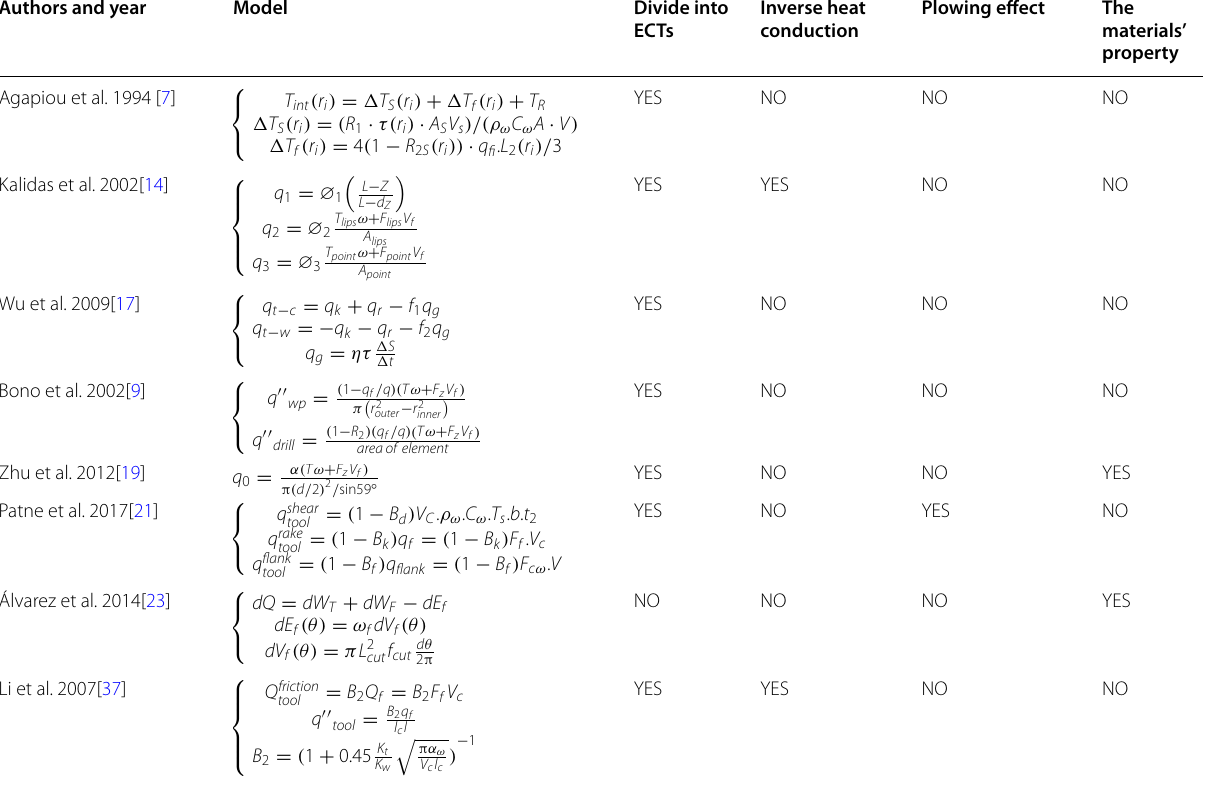
Table 1 Heat flux models in drilling Authors and year Model Divide into